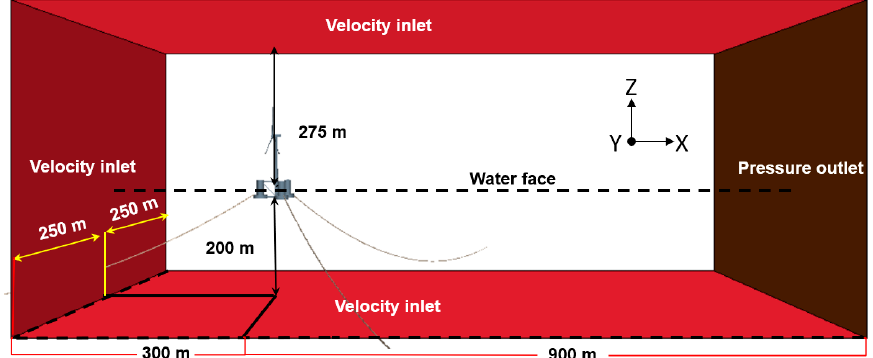
Figure 11. Fully coupled floating offshore wind turbines (FOWT) domain fluid, domain size, and boundary conditions.